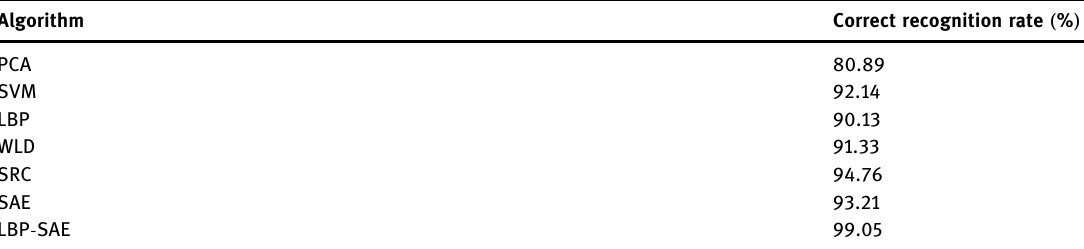
Table 3: Correct recognition rate of di ff erent algorithms on Yale library